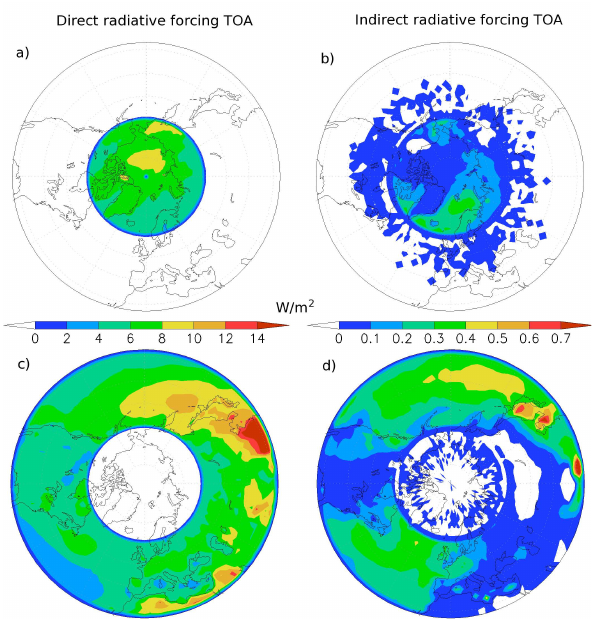
Fig. 3. Annual mean direct radiative forcing (left) and indirect ra- diative forcing (right) at the TOA for the ARC-CONTROL (top) and the MID-CONTROL (bottom). All units in Wm − 2 .